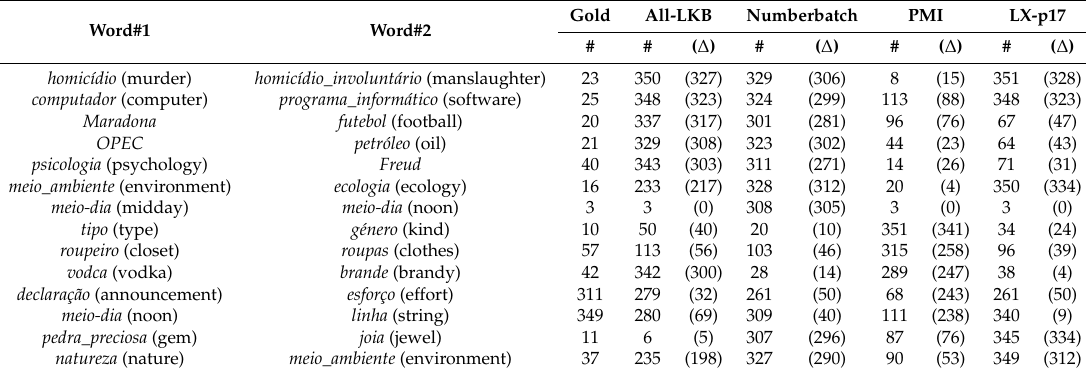
Table 15. Word pairs with higher rank difference ( ∆ ) in procedures using three different databases and gold score in